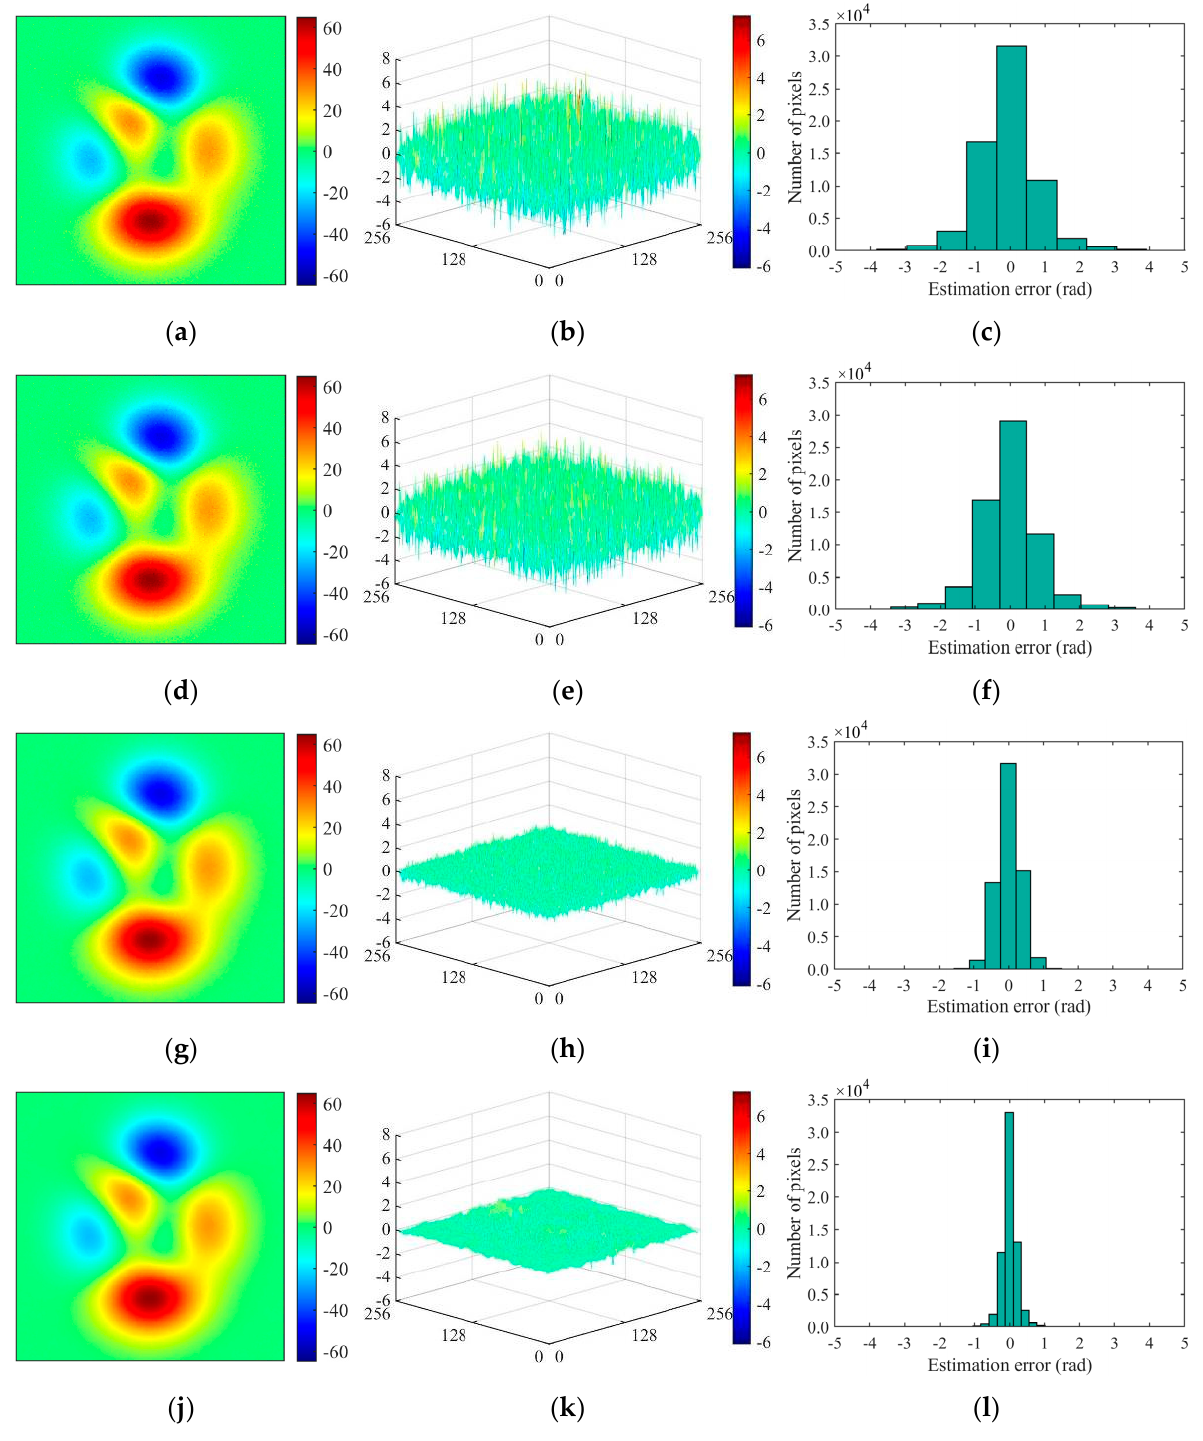
Figure 4. Unwrapped maps (units are rad), PU error distribution maps (units are rad) and estimation error histograms: ( a – c ) are the results obtained by MCF; ( d – f ) are the results obtained by SNAPHU; ( g – i ) are the results obtained by UKFPU; ( j – l ) are the results obtained by